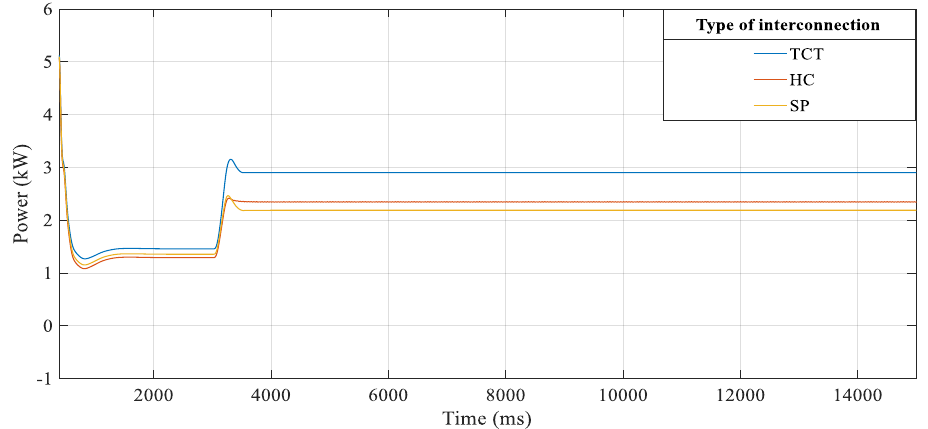
Figure 23. Impact of non-uniform shading fault ‘F3′ on power grid (monocrystalline PV).